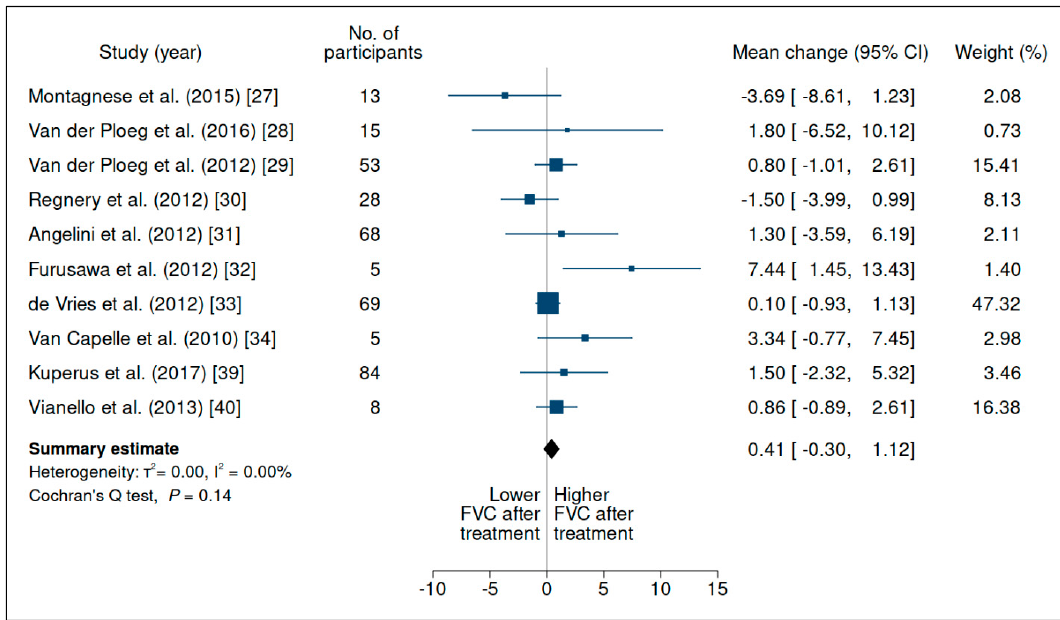
Figure 2. Evaluation of forced vital capacity (% of predicted) in upright position in patients with late-onset Pompe disease on enzyme replacement therapy with alglucosidase alfa. Weights are inverse-variance weights and are proportional to the contribution of each study to the summary estimate. I² is the fraction of variance that is due to statistical heterogeneity and not chance. Tau² denotes the between-study variance